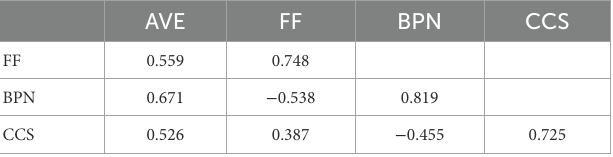
The diagonal data of the matrix represent the square root of the AVE values and the lower half of the matrix represents the correlation coefficient. TABLE 6 Direct effects of independent